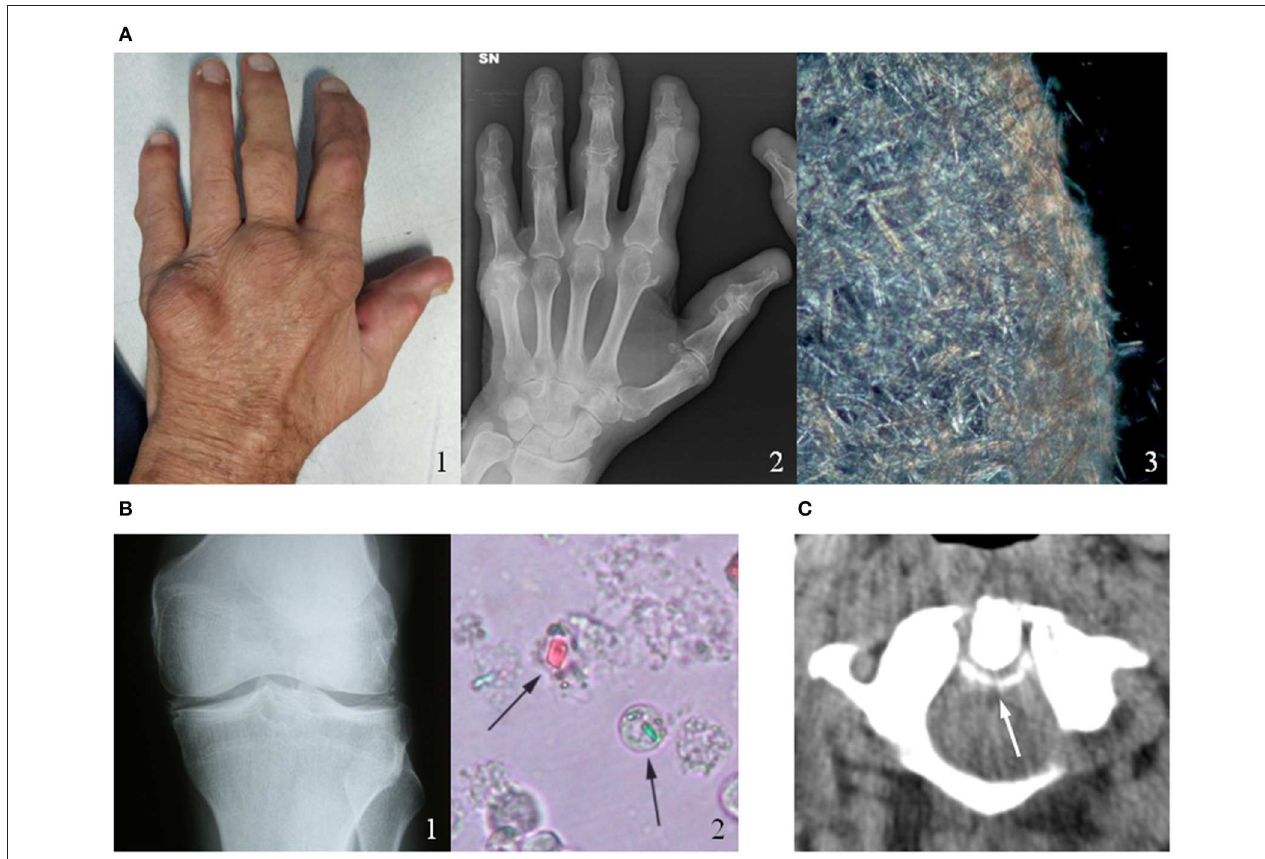
FIGURE 1 | Clinical, radiological and microscopic aspects of gout and calcium pyrophosphate (CPP) crystal deposition. (A) Chronic tophaceous gout (1) with severe joint destructions at radiograph (2) in a male patient with long-standing polyarticular gout. Synovial fluid analysis collected from the V metacarpophalangeal joint showed an aggregate of needle-shape monosodium urate crystals (3). (B) CPP crystal deposition in the knee of a patient with recurrent pseudogout attacks (1). CPP crystals (arrows) observed in synovial fluid under compensated polarized light (2). (C) Axial computed tomography (CT) image of a male patient’s cervical spine at C1-C2, illustrating the “crowning” of the dens. Arrow represents CPP deposition. Original figures obtained and reproduced with patients’ written informed consent to